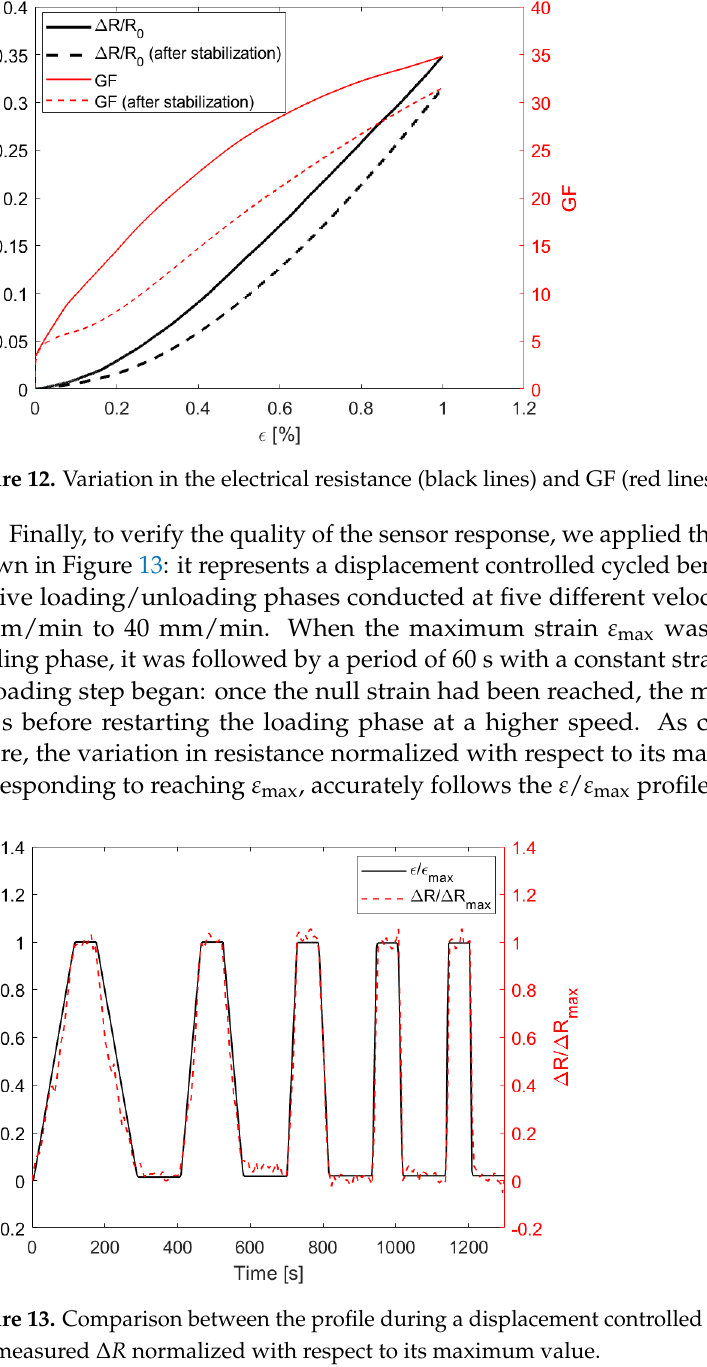
Figure 13. Comparison between the profile during a displacement controlled cycled bending test and the measured ∆ R normalized with respect to its maximum value.